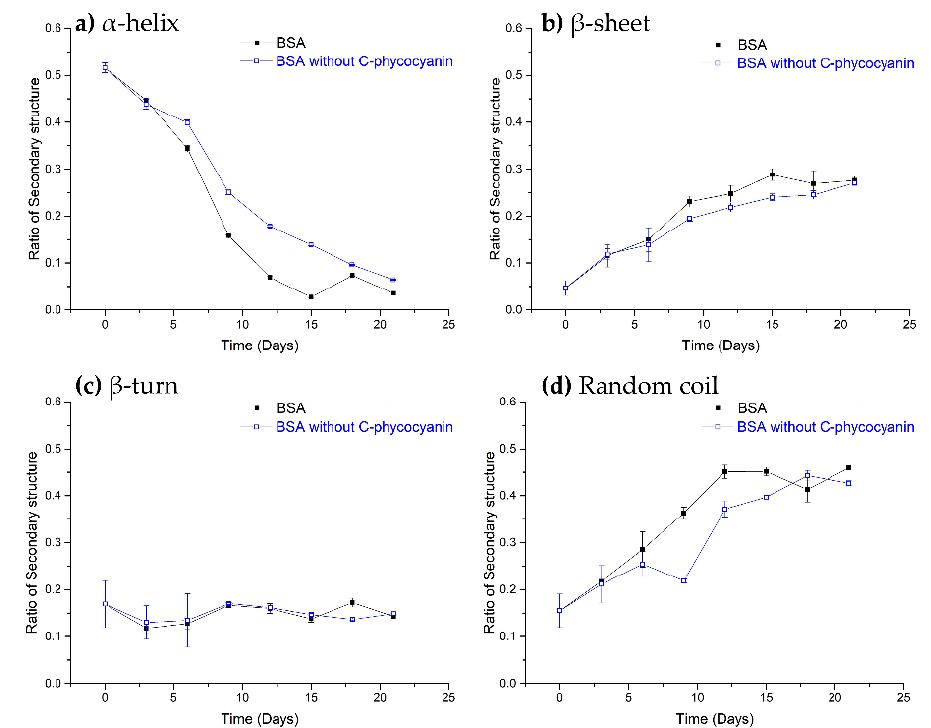
Figure 3. Variation on the secondary structure (( a ), α -helix; ( b ), β -sheet; ( c ), β -Turn; ( d ), random coil) of BSA complexes with C-phycocyanin (50 µg/mL) calculated using the CDSSTR software during a 21-day incubation.